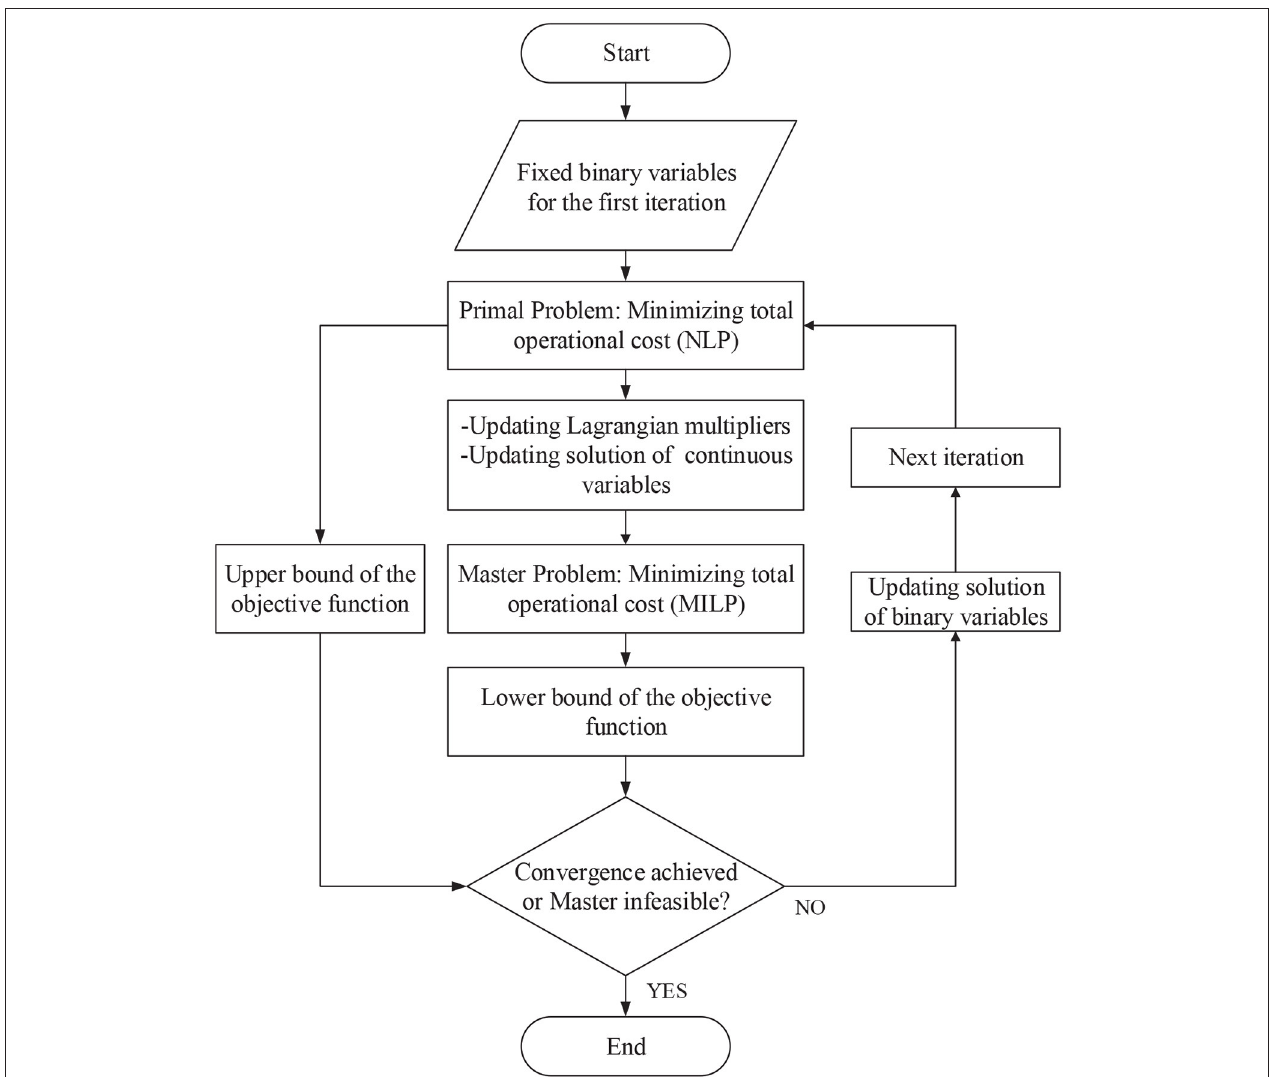
FIGURE 3 | Structure of OA/ER decomposition